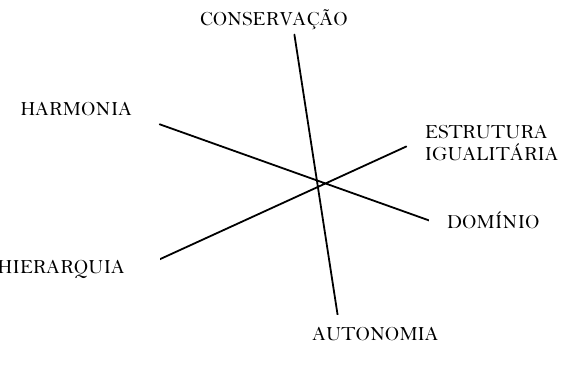
Figura 1. Dimensões bipolares dos valores organizacionais